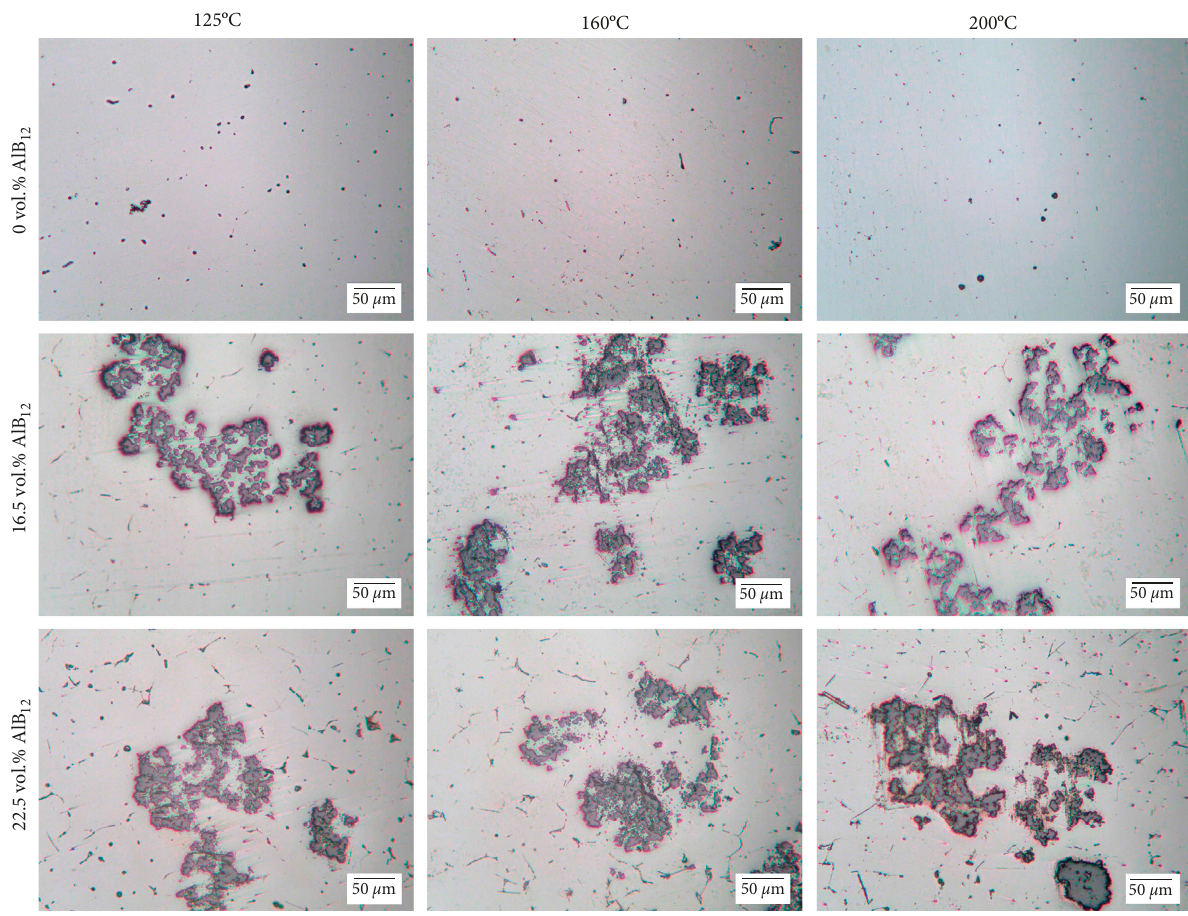
Figure 1: Optical micrographs for Al-5 wt.% Zn samples containing 0, 16.5, and 22.5 vol.% AlB followed by slow cooling.